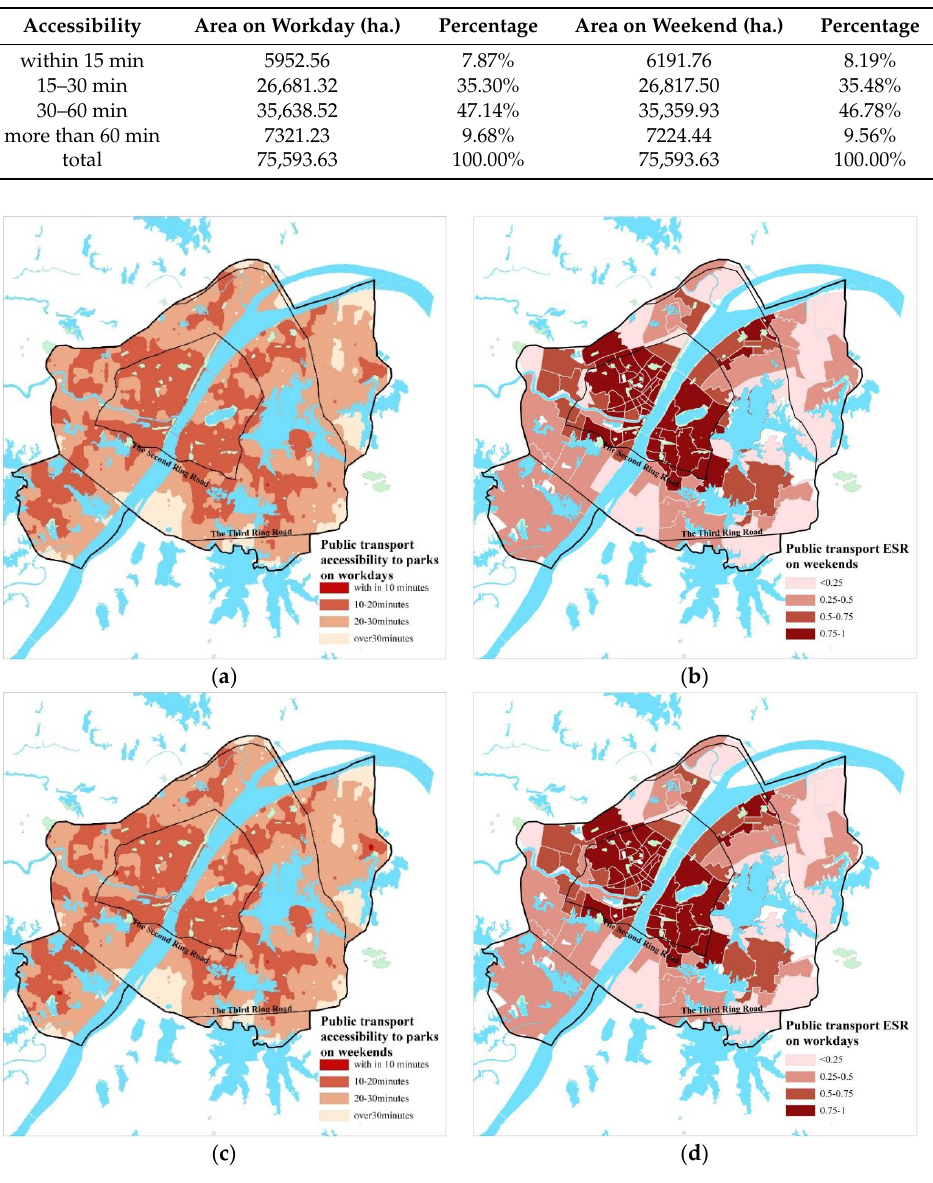
Figure 5. ( a ) Spatial distribution of public transport accessibility on workdays; ( b )Spatial distribution of public transport ESR on workdays; ( c ) Spatial distribution of public transport accessibility on weekdays; ( d ) Spatial distribution of public transport ESR on weekends.